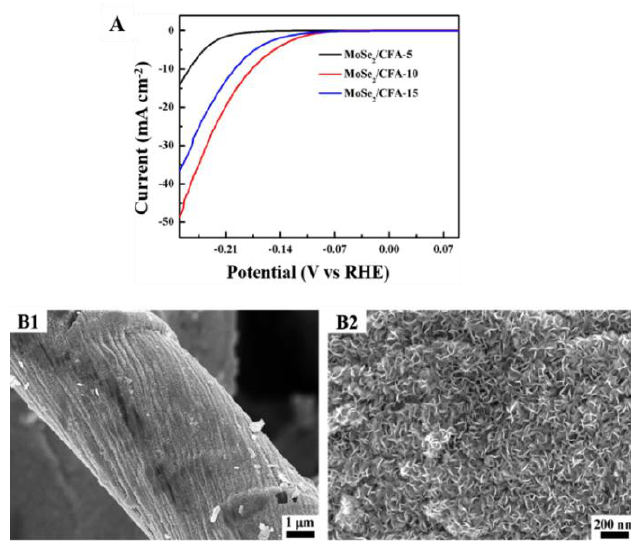
Figure 3. ( A ): Linear Sweep Voltammetry (LSV) polarization curves for MoSe 2 /CFA (Carbon Fiber Aerogel) hybrid modified Glassy Carbon Electrode GCE. ( B ): FESEM images of MoSe2/CFA hybrid ( B1,B2 ). Reproduced from [68] with permission of the American Chemical Society 2020.